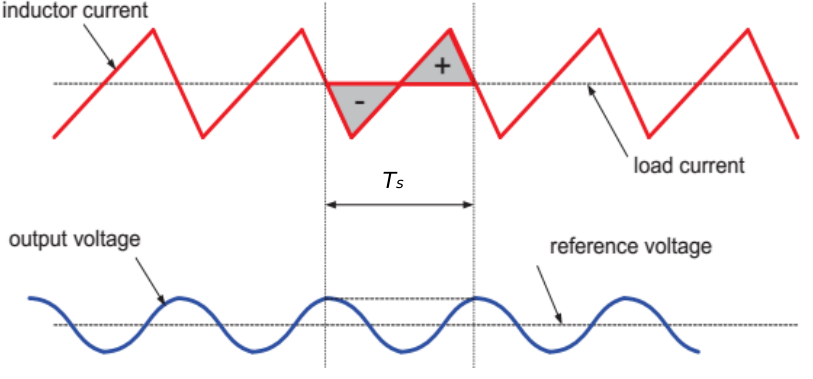
Figure 10. Waveforms of buck converter under steady-state.